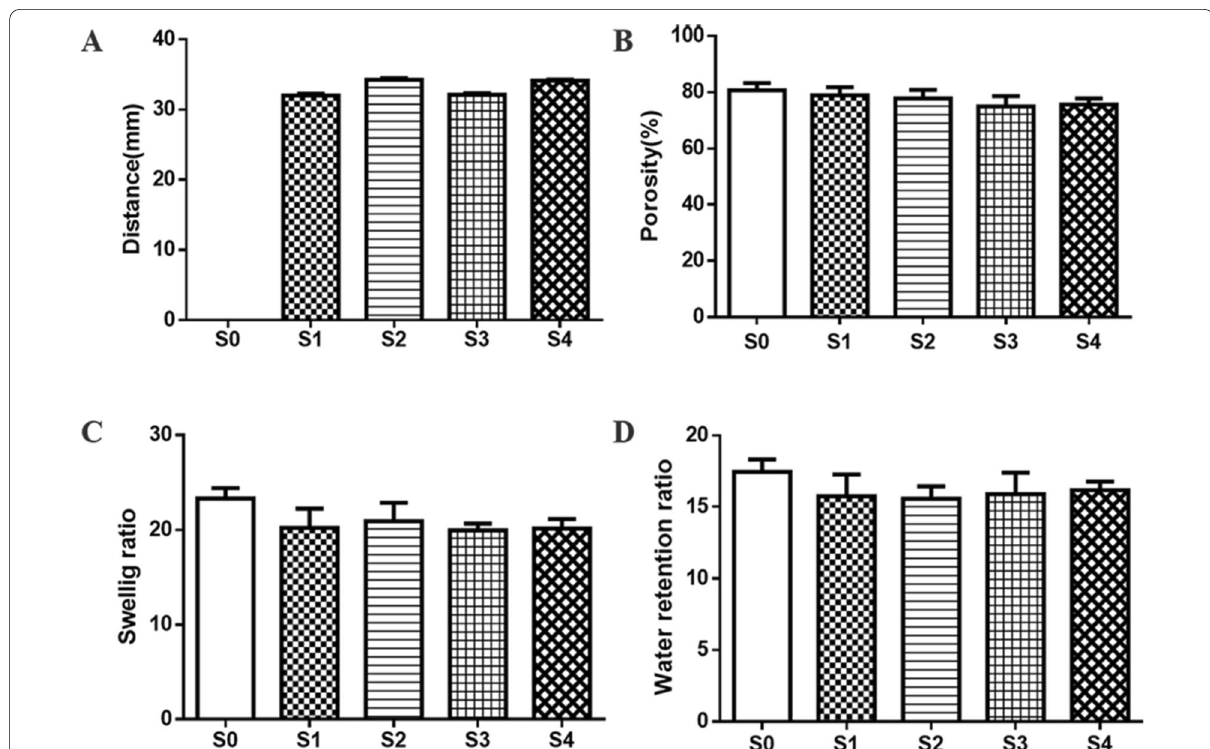
Fig. 5 Analysis of physicochemical properties of scaffolds. A The distance between the magnet and the liquid level. The magnetic responsiveness of the scaffolds was positively correlated with the distance. B The porosity of scaffolds. C The swelling ratio of scaffolds. D The water retention ratio of